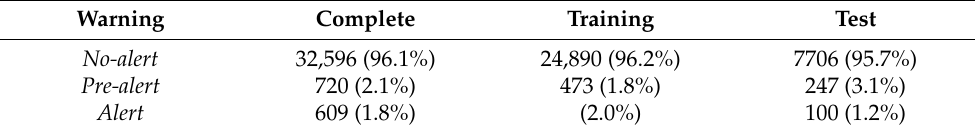
Table 4. The number of samples and relative percentage for the entire dataset and the training and test subsets.